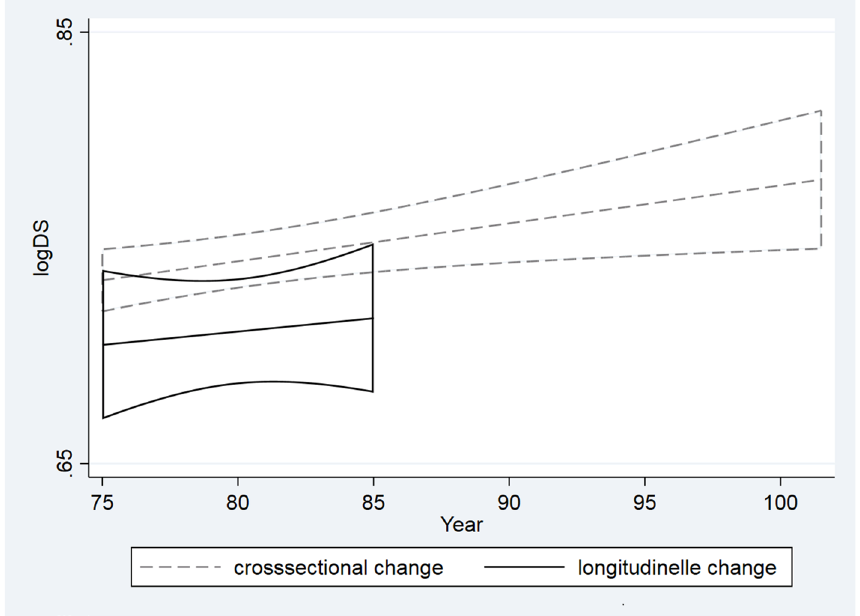
Figure 3. Cross-sectionally and longitudinally estimated changes in degree of skewed X-chromosome inactivation (DS) with age. Ten-year longitudinal changes of DS at baseline (1997) and follow-up (2007) in LSADT. Cross-sectional age changes were estimated using the LSADT (1997) and the 1905 birth cohort at 93 years of age and the 1895 centenarians.